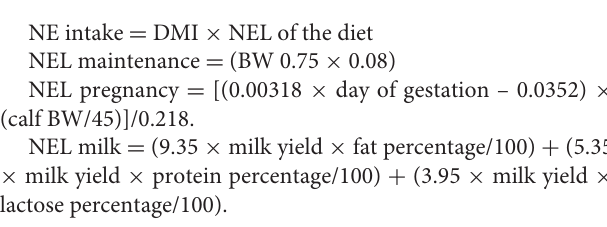
TABLE 1 | Frequency table of digestive disorders during the first 28 days postpartum in 689 cows. Disorder